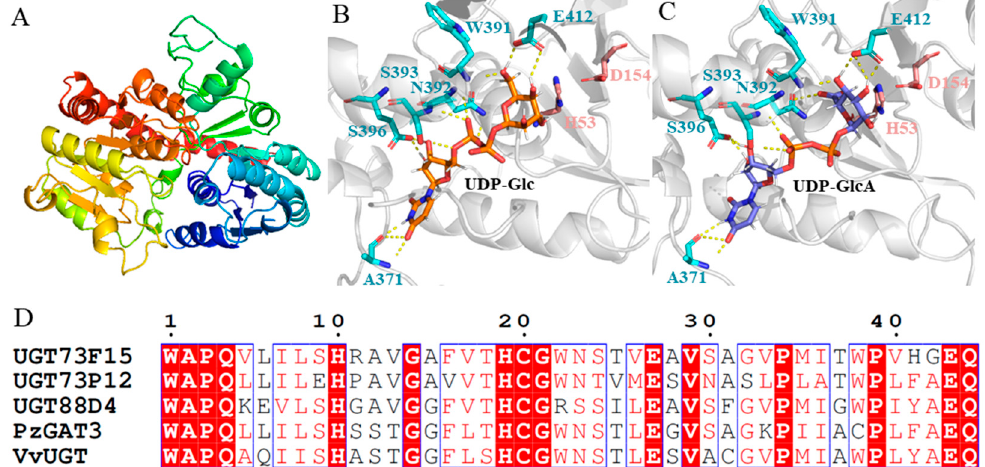
Figure 4. Sugar donor (UDP-GlcA) recognition of UGT73F15. ( A ) Homology model of UGT73F15 using glycosyltransferase PaGT3 from Phytolacca americana as template. ( B ) Interaction analysis between UDP-Glc and UGT73F15 in the docking model. Hydrogen bonds are represented by yellow dashed lines. Residues involved in the interaction with UDP-Glc are shown in blue sticks. Catalytic residues are shown in pink sticks. UDP-Glc is shown in yellow sticks. ( C ) Interaction analysis between UDP-GlcA and UGT73F15 in the docking model. UDP-GlcA is shown in purple/blue sticks. ( D ) PSPG-box sequence alignment of UGT73F15 and other UGTs identified with UDP-GlcA activity.